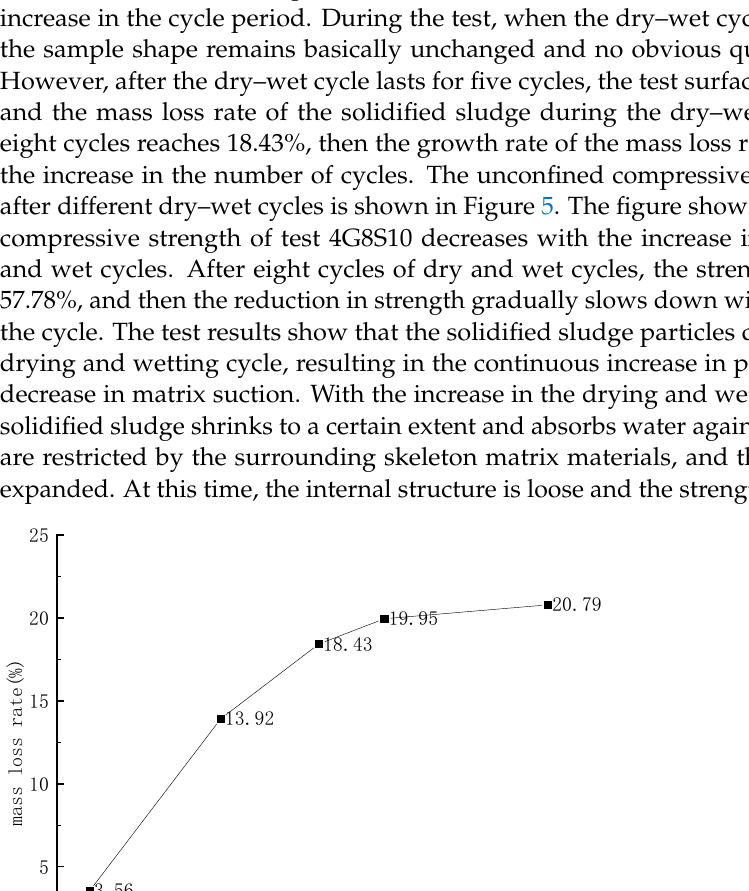
Figure 5. Intensity variation in 4G8S10 under different wet and dry cycles. 3.3. Permeability Combined with the test results of water resistance, the G8 and G8S10 groups of so- lidified sludge samples were selected in this experiment to study the change in permea- bility coefficient before and after the dry – wet cycle. The permeability coefficient of sam- ples G8 and G8S10 is shown in Figure 6. It can be seen from the figure that the permeability coefficient of sample G8S10 is 2.00 × 10 −7 cm/s, a permeability coefficient of 3.20 compared with sample G8 at 1 × 10 −8 cm/s. This increase of one order of magnitude indicates that the addition of building debris increases the fine pores between solidified sludge particles, provides a seepage channel for the solidified sludge and enhances the permeability. After eight cycles of drying and wetting, the permeability coefficient of sample G8S10 has in- creased by one order of magnitude and the permeability coefficient of sample G8 has in- creased by two orders of magnitude. This increase indicates that the internal pores of sam- ple G8 and G8S10 become larger due to the effect of drying and wetting cycles, and some of the pores between particles develop into inside particle pores, leading to an increase in the permeability coefficient. Meanwhile, the skeleton role of the skeleton material in the solidified sludge increases its resistance to drying and wetting cycles.